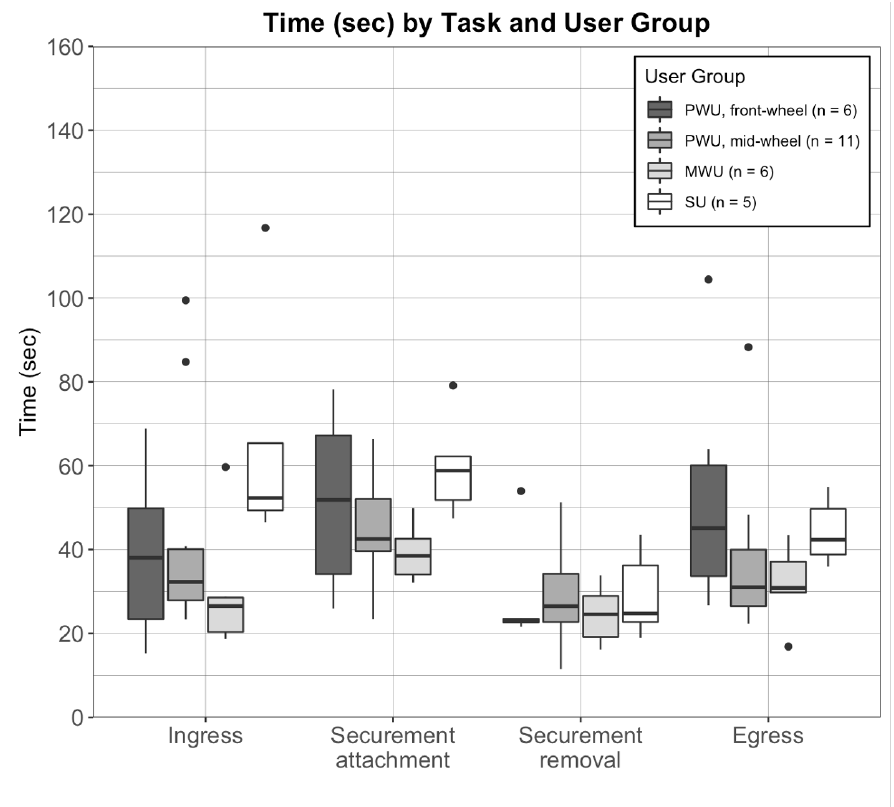
Figure 3. Box-plots of tasks times (seconds) for ingress, mobility device securement attachment and removal, and egress, averaged across 3 bus trips per participant and stratified by user group: mid- wheel (n = 6) and front-wheel (n = 11) drive powered wheelchair users (PWU), manual wheelchair users (MWU; n = 6), and scooter users (SU; n = 5). Dots indicate statistical outliers (i.e., values greater than 1.5 times the inter-quartile